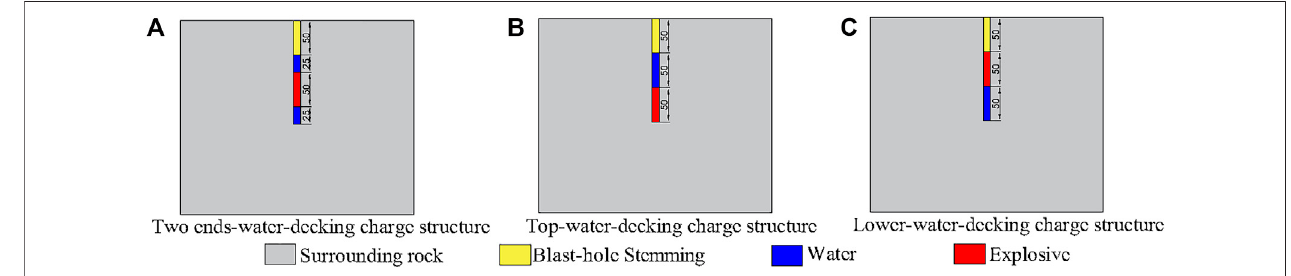
FIGURE 9 | Schematic diagram of different charge structures for hydraulic blasting (unit: cm). (A) Two ends-water-decking charge structure. (B) Top-water- decking charge structure. (C) Lower-water-decking charge structure.